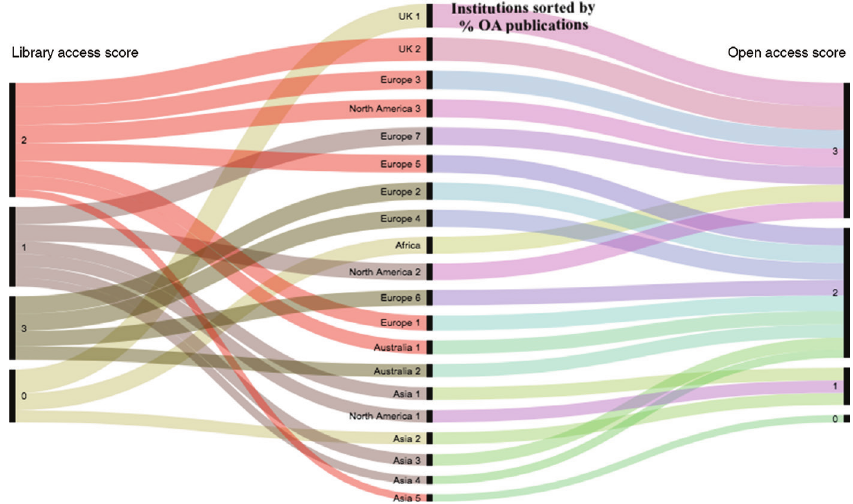
Fig. 6: Library access scores, institutions by percentage of 2017 OA publications, Open Access scores. Source of OA publications data: Microsoft Academic, Scopus, Web of Science, Unpaywall, Crossref. Curtin Open Knowledge Initiative,